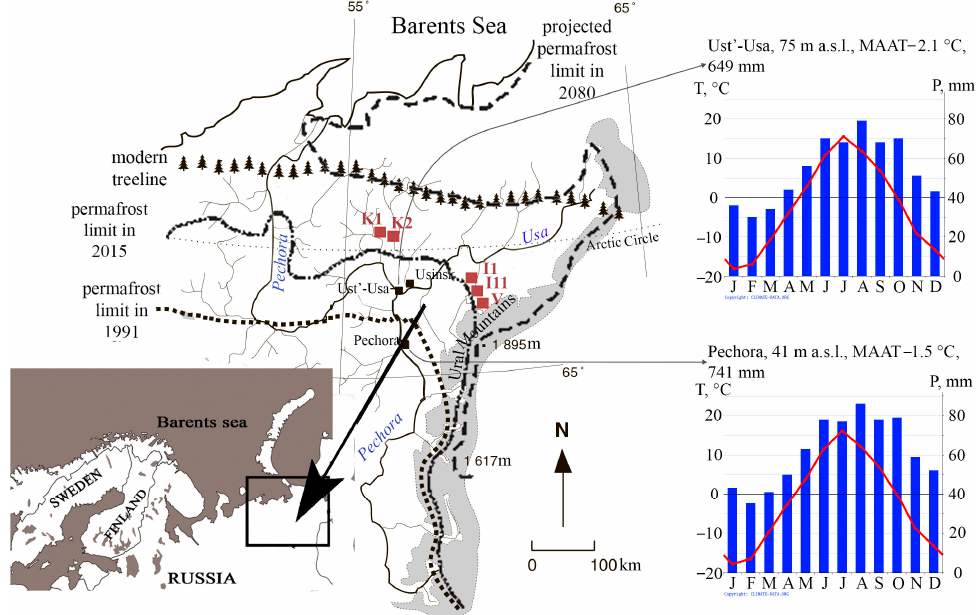
Figure 7. Key study sites: Inta 1, Inta 11, Kolva, and Voda-Ty (indicated by red squares). The closest climate stations are marked by black squares. Monthly air precipitation and temperatures were based on the climate database https://ru.climate-data.org/ (accessed on 31 August 2022)